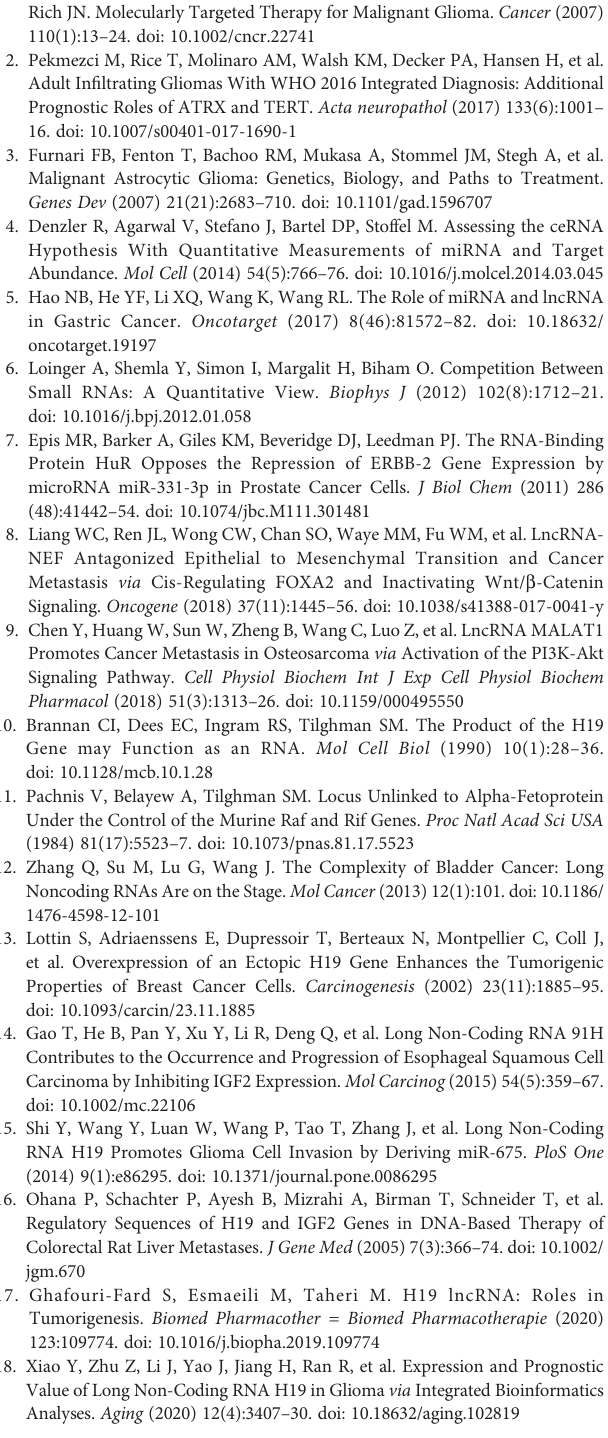
Supplementary Figure 2 | (A – D) The invasion and migration of transfected U251 cells were examined using Transwell assay. Data were presented as mean ± SEM; * P < 0.05 vs control group. NC, negative